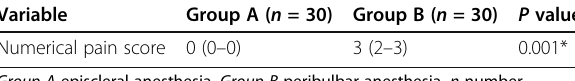
Table 8 Comparison between group A and B as regards NPS